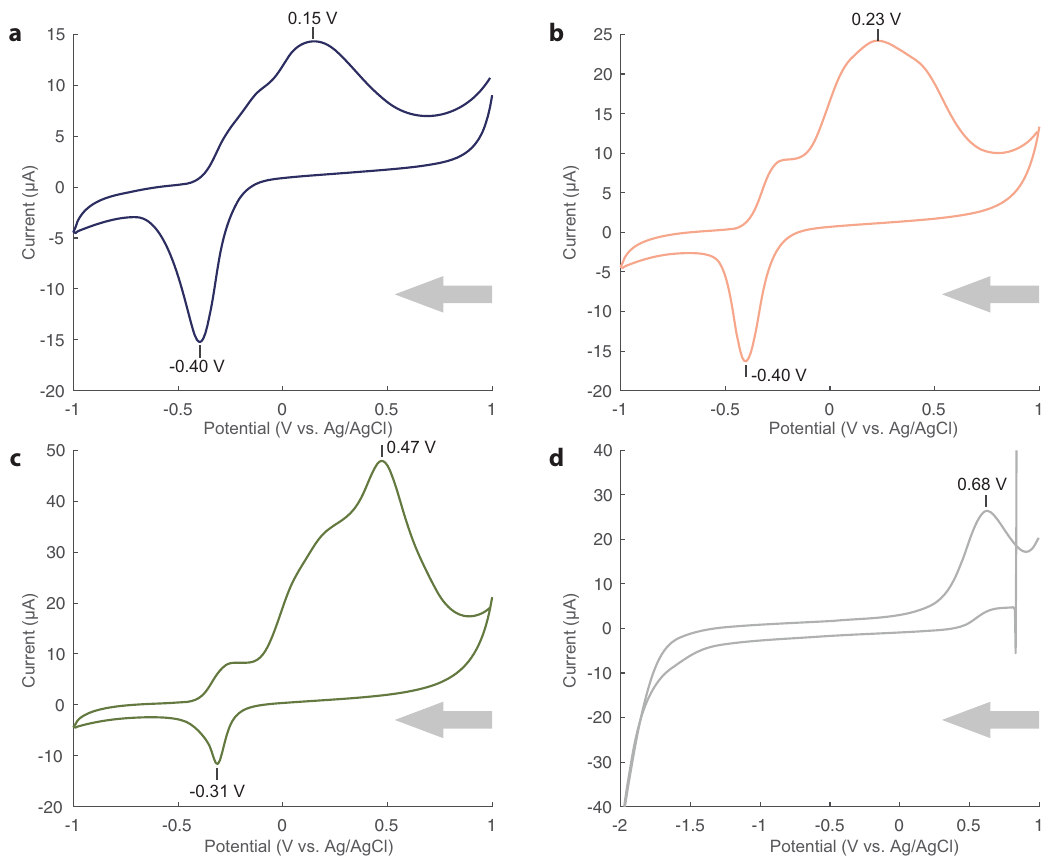
Fig. 8 Reduction potentials of Cys-FeS clusters re fl ect those of Fd proteins. Cyclic voltammograms of Cys-FeS clusters formed at pH 9 in the presence of a 3.5 mM, b 5 mM or c 10 mM L-cysteine, with FeCl 3 and Na 2 S at equimolar 1 mM concentrations. d 10 mM L-cysteine alone. Cyclic voltammograms were performed at a scan rate of 100 mV/S. Potentials (V, versus Ag/AgCl (3 M NaCl)) are marked for the apex of each cathodic and anodic peak. Arrows indicate the scanning direction. Source data are provided as a Source data fi